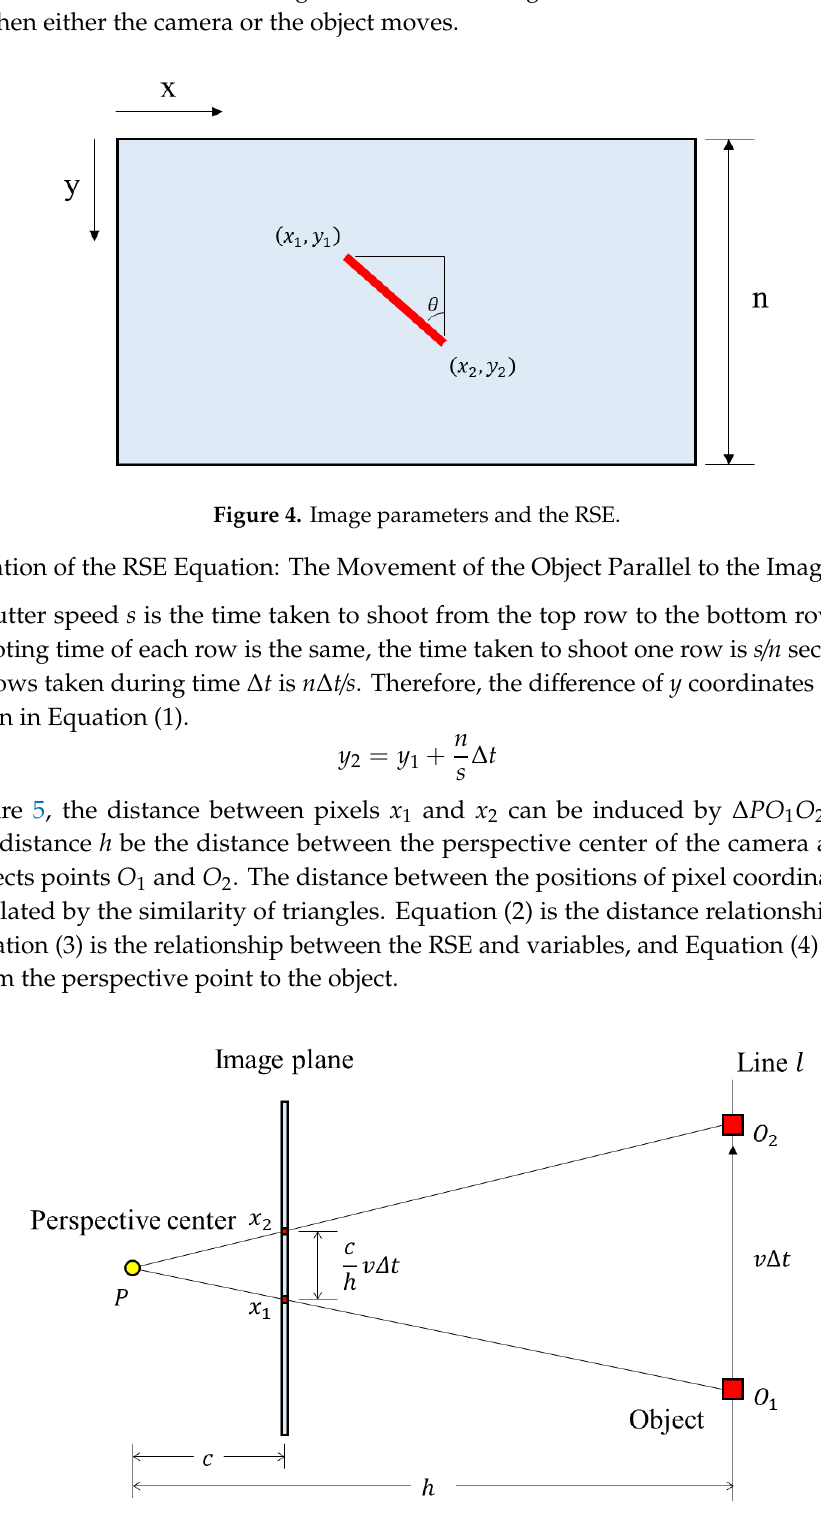
Figure 4. Image parameters and the RSE .